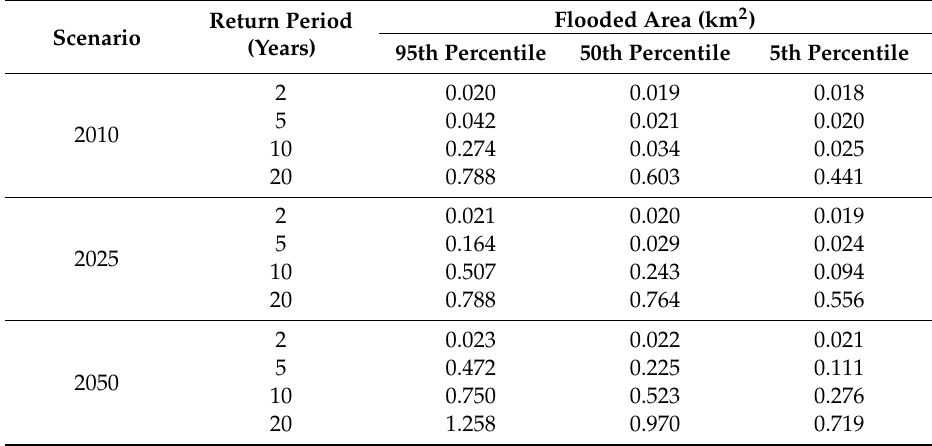
Table 2. Flooded area for each scenario, return period, and percentile of the a T